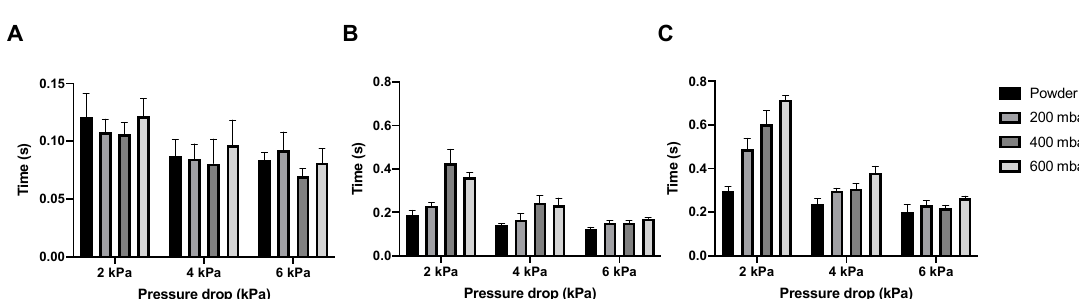
Figure 7. The dispersion times for 55 mg isoniazid. Panel ( A ) shows the time it took to empty the SDC, panel ( B ) shows the time it took for the bulk of the powder to be dispersed, and panel ( C ) shows the time needed to disperse the complete dose (average ± SD, n = 5).